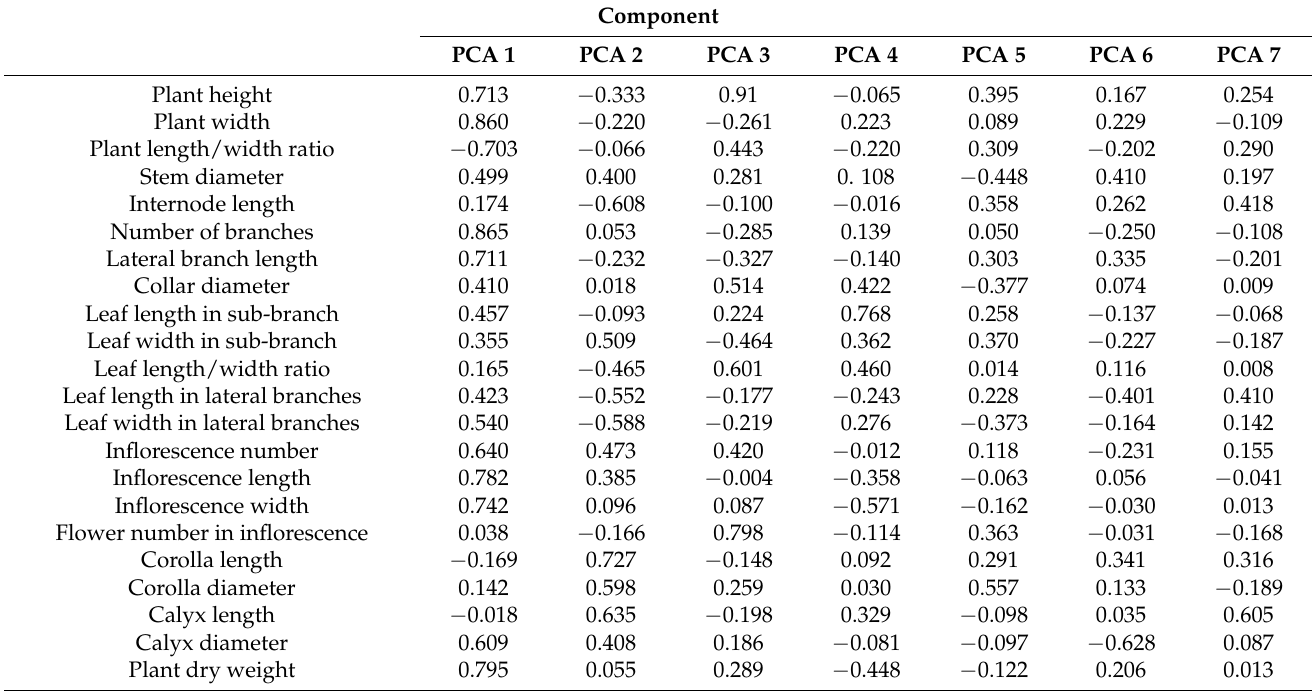
Table 5. PCA analysis for morphological traits of M. aquatica populations from the Hyrcanian hotspot of